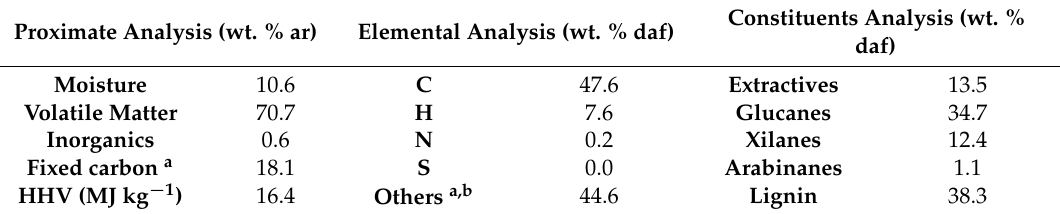
Table 9. Chemical analysis of the original biomass